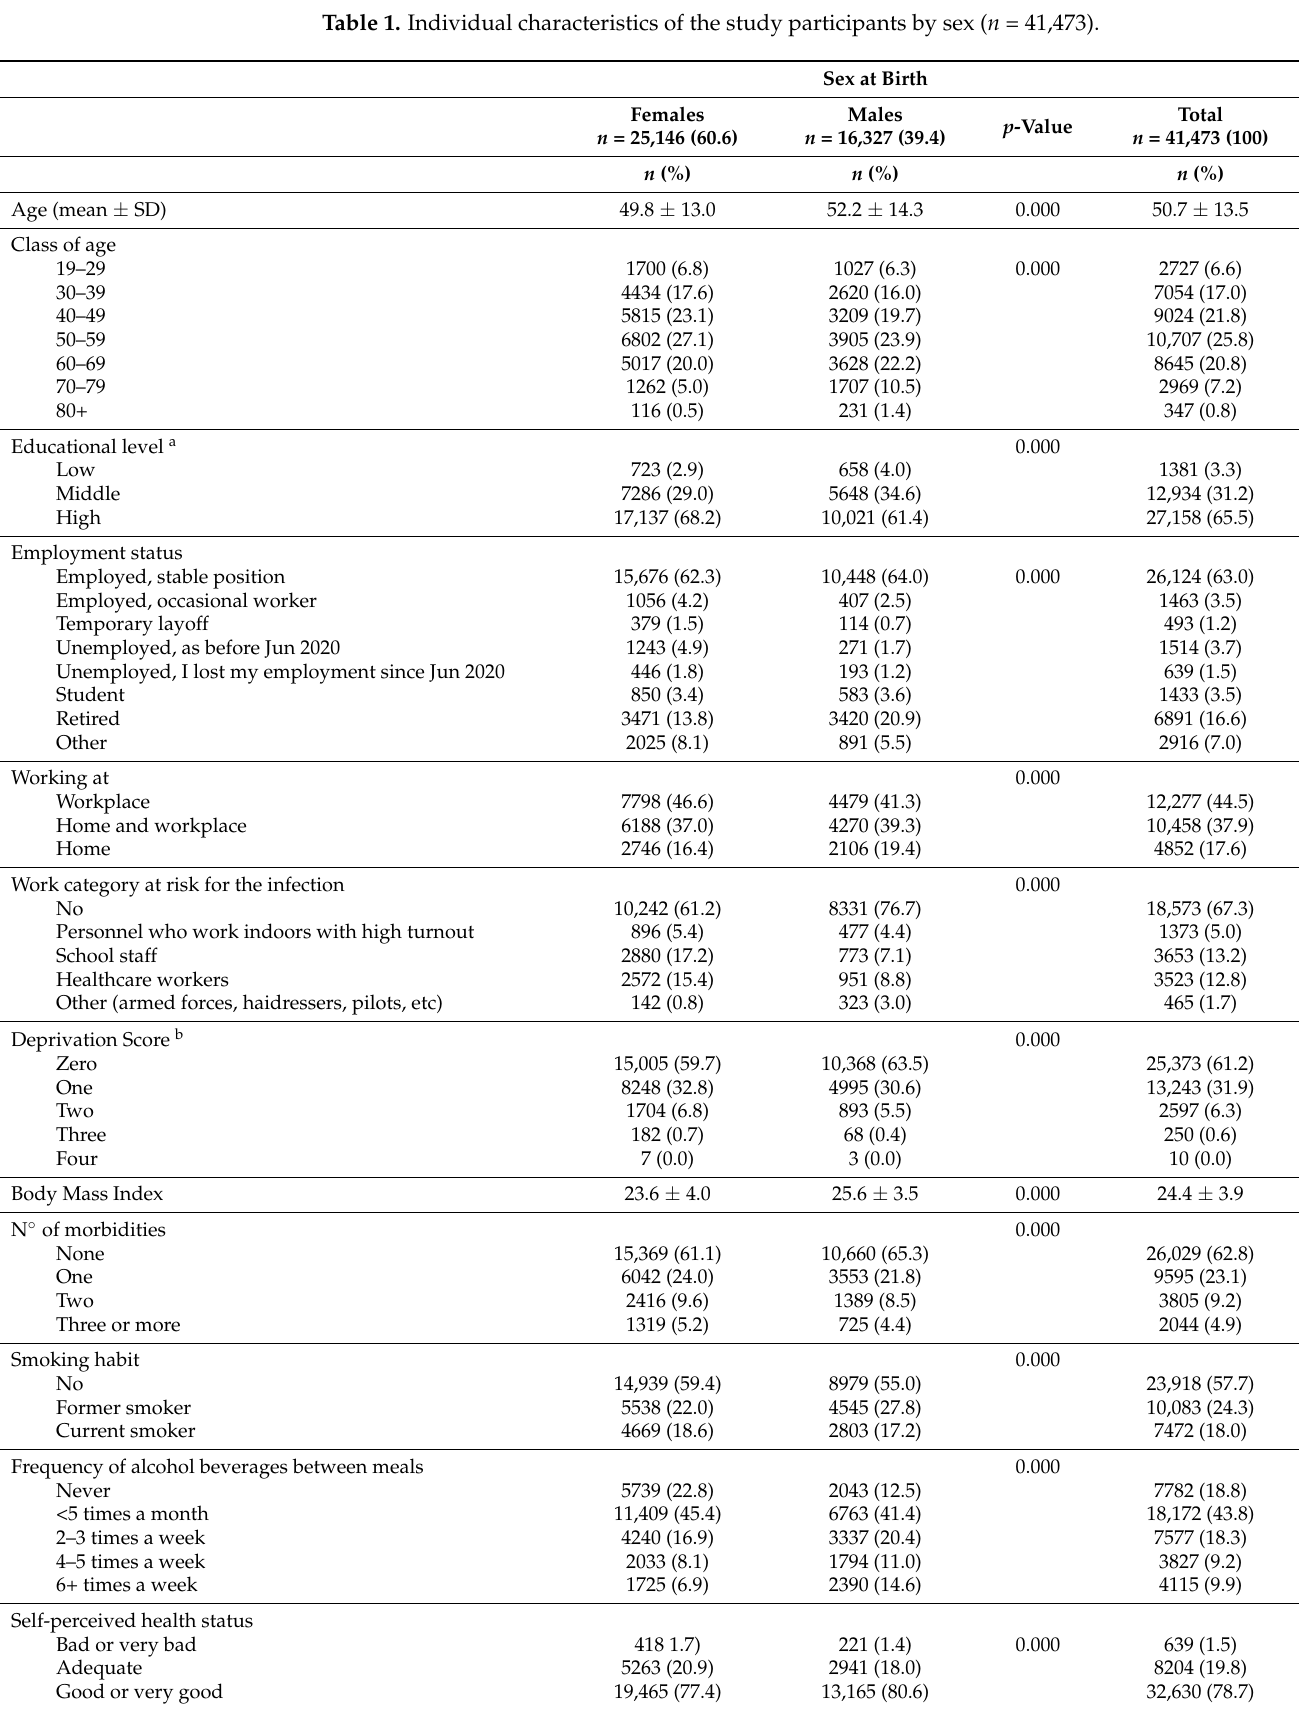
Table 1. Individual characteristics of the study participants by sex ( n =